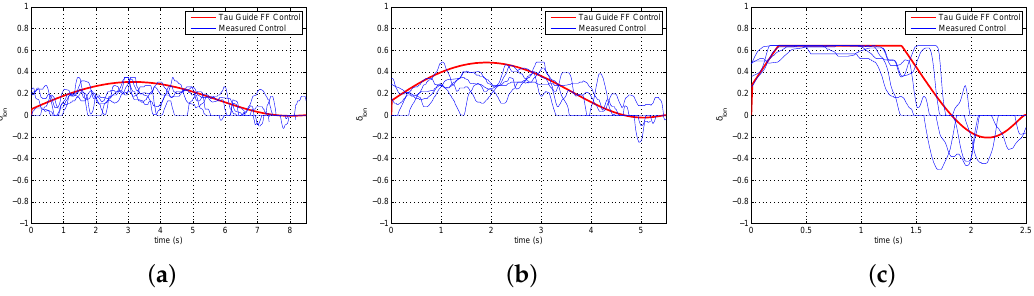
Figure 11. Augmented flight control provides a feed-forward control signal to partially automate the step task. A tau guide creates a reference velocity that is converted to a helicopter control signal. The subfigures show the comparison of the generated signal against a set of control human controls. ( a ) Control for Step Task at Slow Speed; ( b ) Control for Step Task at Medium Speed; ( c ) Control for Step Task at Fast